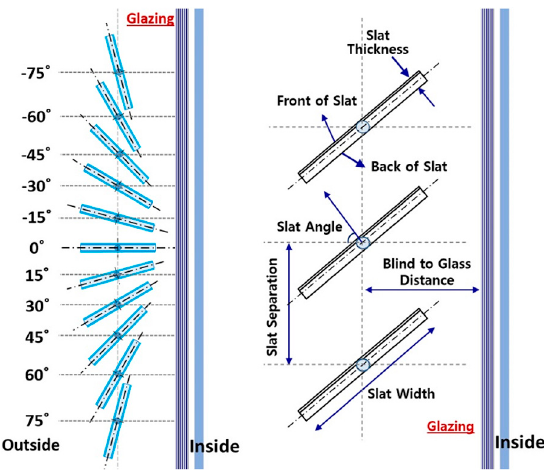
Figure 7. Properties of the venetian blind [60]. Table 6. Set of the venetian blind slat angle and dimensions.